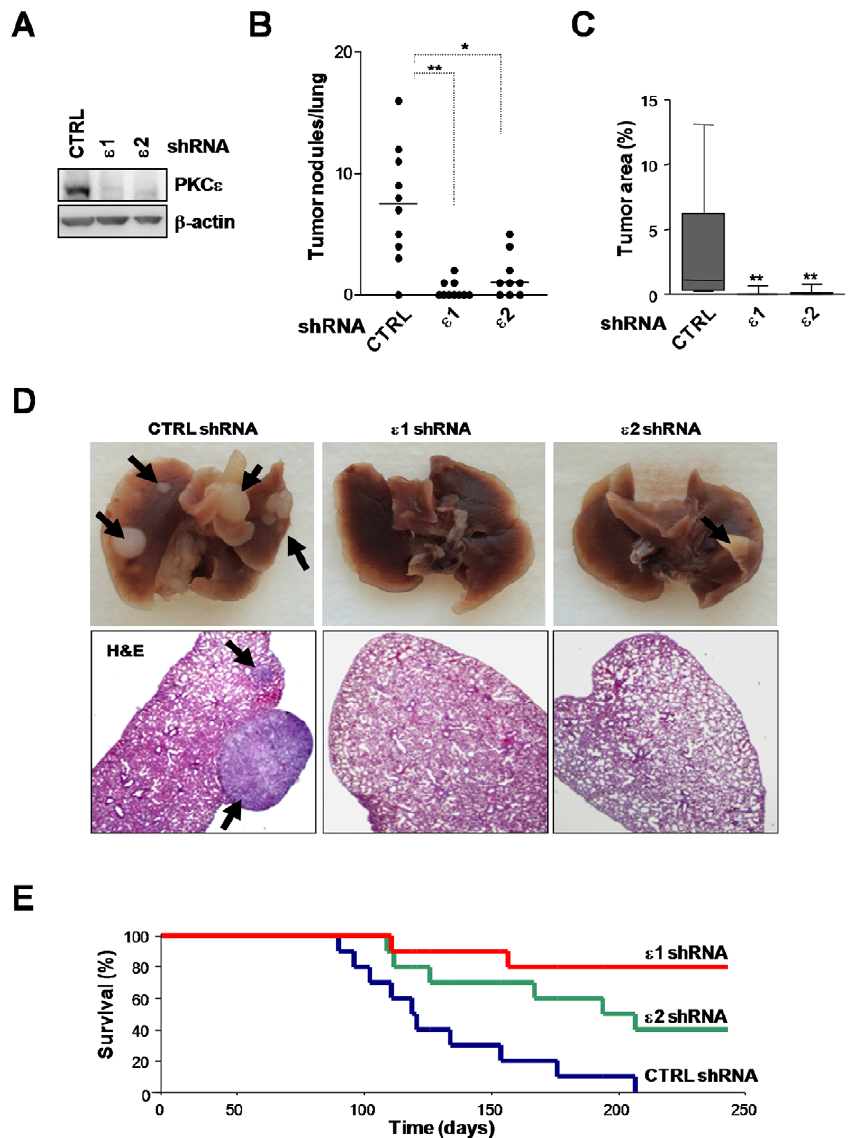
Figure 7. PKC e plays a role in invasion and metastatic dissemination of NSCLC cells. A549 cells were subject to stable PKC e depletion using two different shRNA lentiviruses ( e 1 and e 2) or control cells ( CTRL , non-target shRNA lentivirus) and selected with puromycin. Cells were inoculated i.v. into athymic mice. A. Levels of PKC e depletion achieved in stable cells lines. A representative Western blot is shown. B. Incidence of metastasis per lung in mice sacrificed 100 days post-inoculation of cells. *, p , 0.05; **,p , 0.01. C. Area of tumors as determined in microscopic images. **, p , 0.01. D. Representative images of lungs from mice inoculated with PKC e -depleted or control cells. Arrows , metastatic foci in whole-fixed lungs ( top panels ) or in lungs stained with hematoxilin and eosin (H&E) ( bottom panels ). E. Overall survival of mice inoculated with PKC e -depleted or control A549 cells.